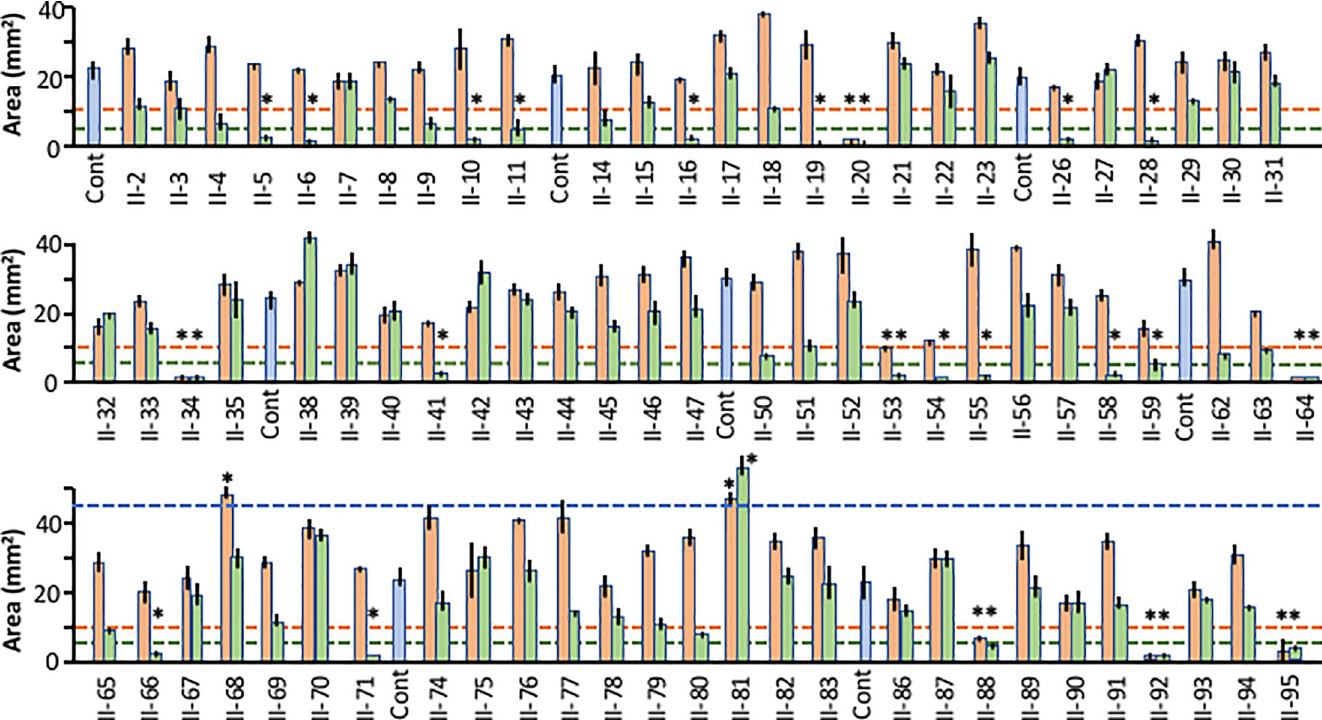
Fig 5. Effects of Library II inhibitors. Explant areas at 9 DIV for Library II, showing areas for control, explants (DMSO alone, blue bars) and inhibitors at concentrations of 0.5 (orange bars) and 5.0 μ M (green bars). The criterion threshold of growth suppression for each inhibitor concentration is shown as a dashed line. The criterion threshold for growth enhancement, induced by only two inhibitors, is indicated by a dashed blue line. Inhibitors and concentrations that met the criterion thresholds are indicated by asterisks. All Library II inhibitors and their targets are listed in Table 2.